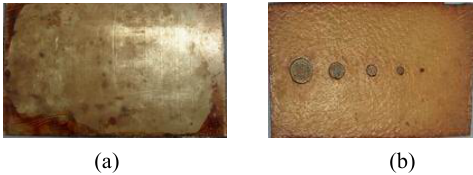
Fig. 12 Photo of the specimen 2#: (a) front surface and (b) back